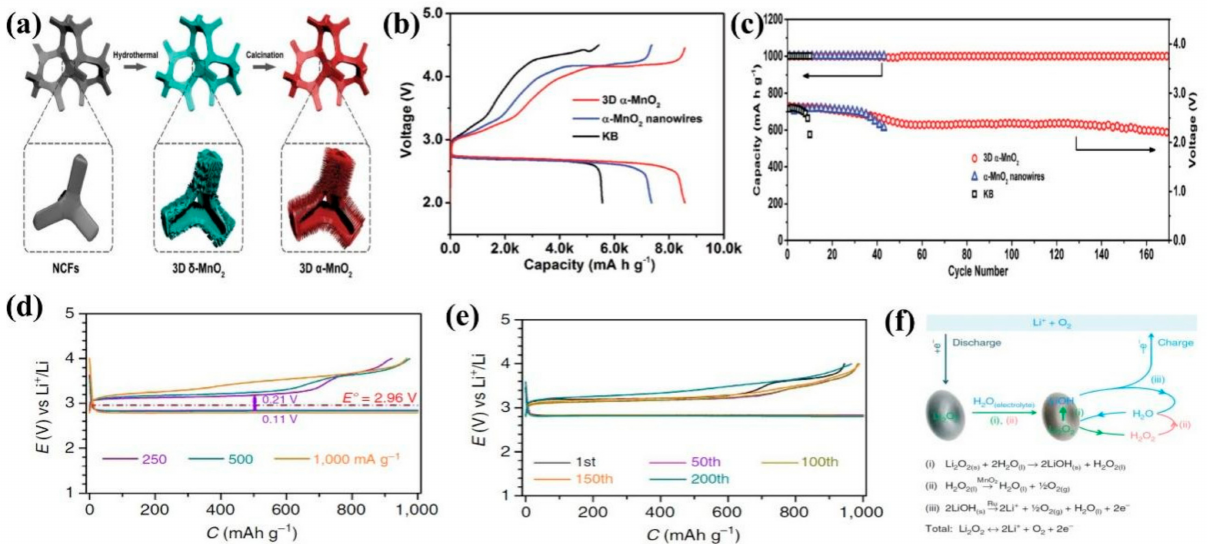
Figure 10. ( a ) Schematic diagram of 3D void α -MnO 2 frame fabrication. 3D void α -MnO 2 Discharge and charge curves ( b , c ) and cycle performance of MnO 2 nanowires and KB catalyst lithium oxygen battery at 100 mA g − 1 and 200 mA g − 1 with a limited capacity of 1000 mA h g − 1 , respectively. Reprinted with permission from ref. [146]. Copyright 2019 John Wiley and Sons. ( d ) Discharge/charge profiles of the tenth run at varied Rate capability and ( e ) cycling performance of Li-O 2 battery with EMD/Ru/SP cathode. ( f ) Proposed reaction mechanism of EMD/Ru/SP cathode. Reprinted with permission from ref. [157]. Copyright 2015 Springer